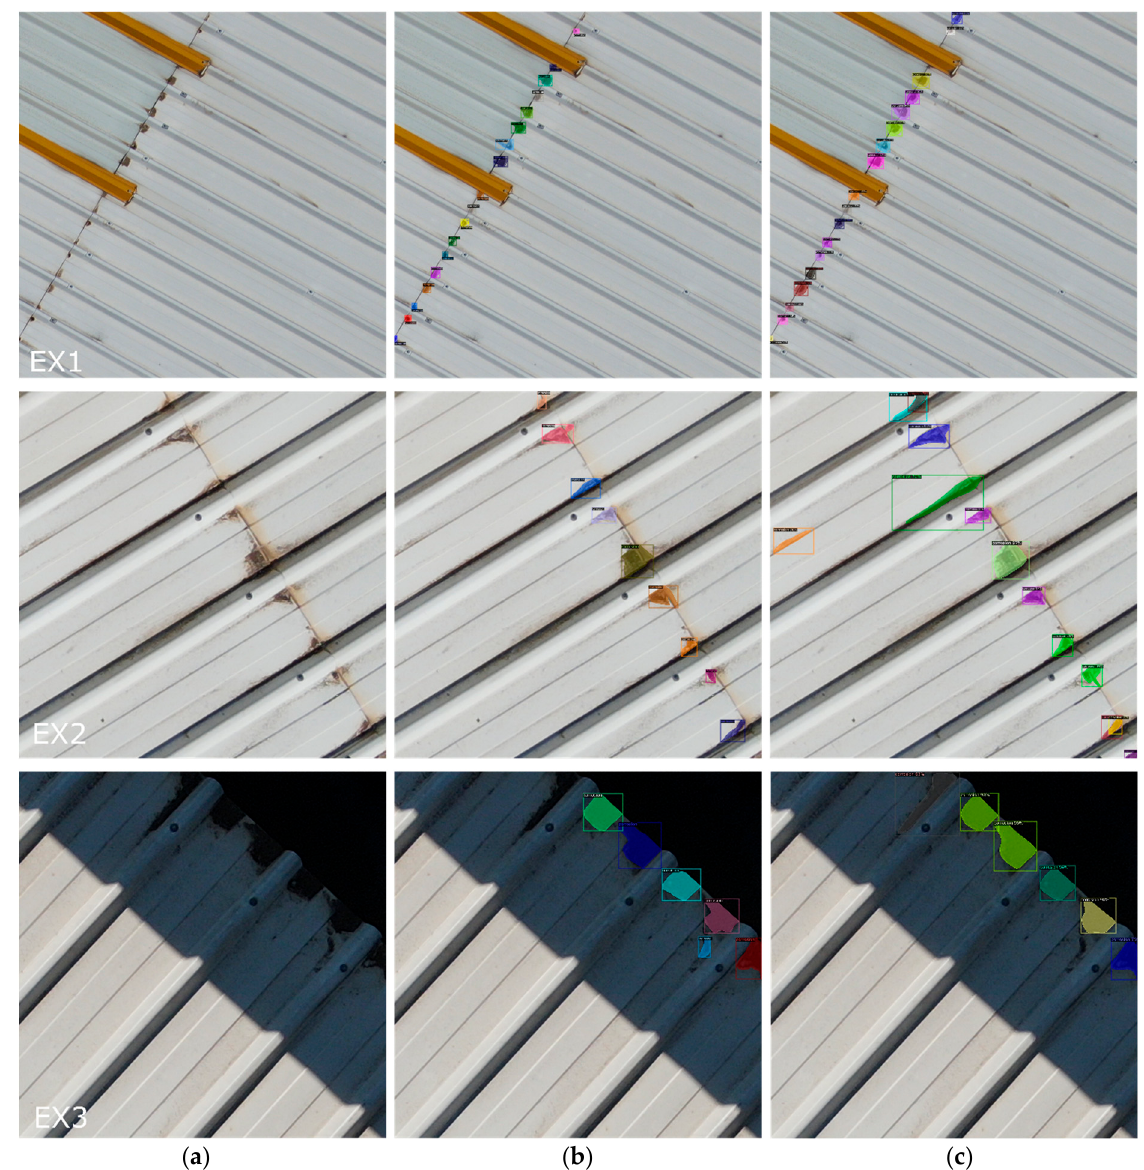
Figure 16. Examples of classification with small instances/poor illumination conditions (EX1 to EX3): ( a ) original image, ( b ) ground truth, and ( c ) prediction.